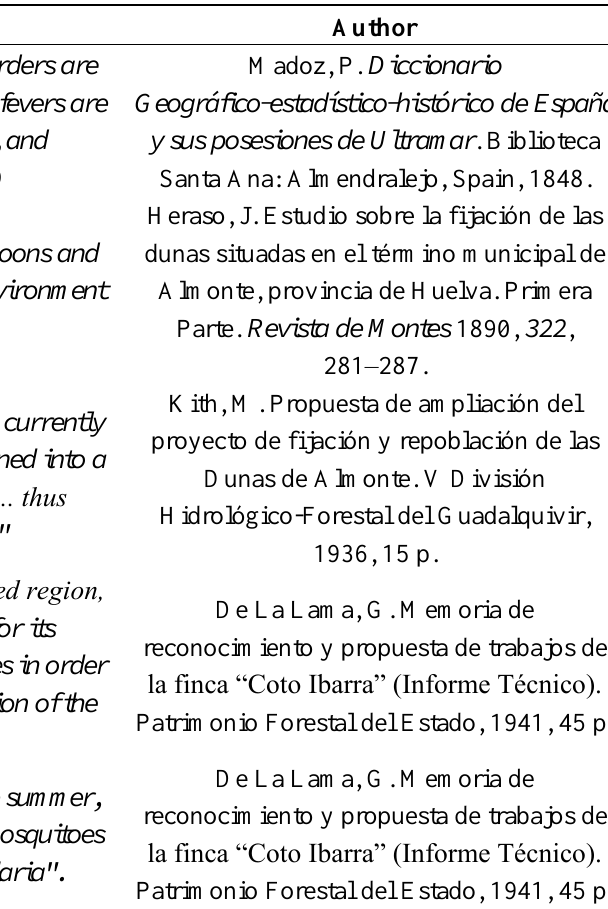
Table A1. Text from the 19th and mid 20th centuries elaborated by the people in charge of the desiccation of coastal lagoons from the province of